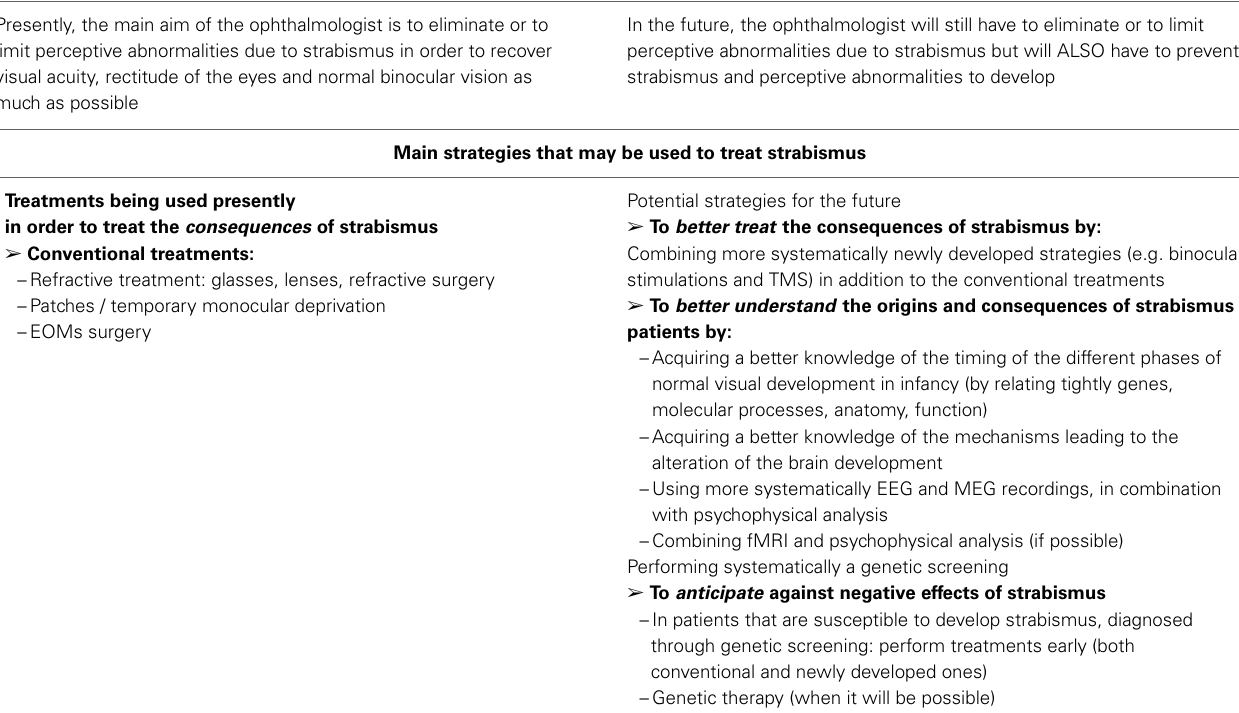
Table 3 | Main objectives and main strategies of the ophthalmologist in case of strabismus. Main objectives of the opthalmologist in case of strabismus Presently, the main aim of the ophthalmologist is to eliminate or to limit perceptive abnormalities due to strabismus in order to recover visual acuity, rectitude of the eyes and normal binocular vision as much as